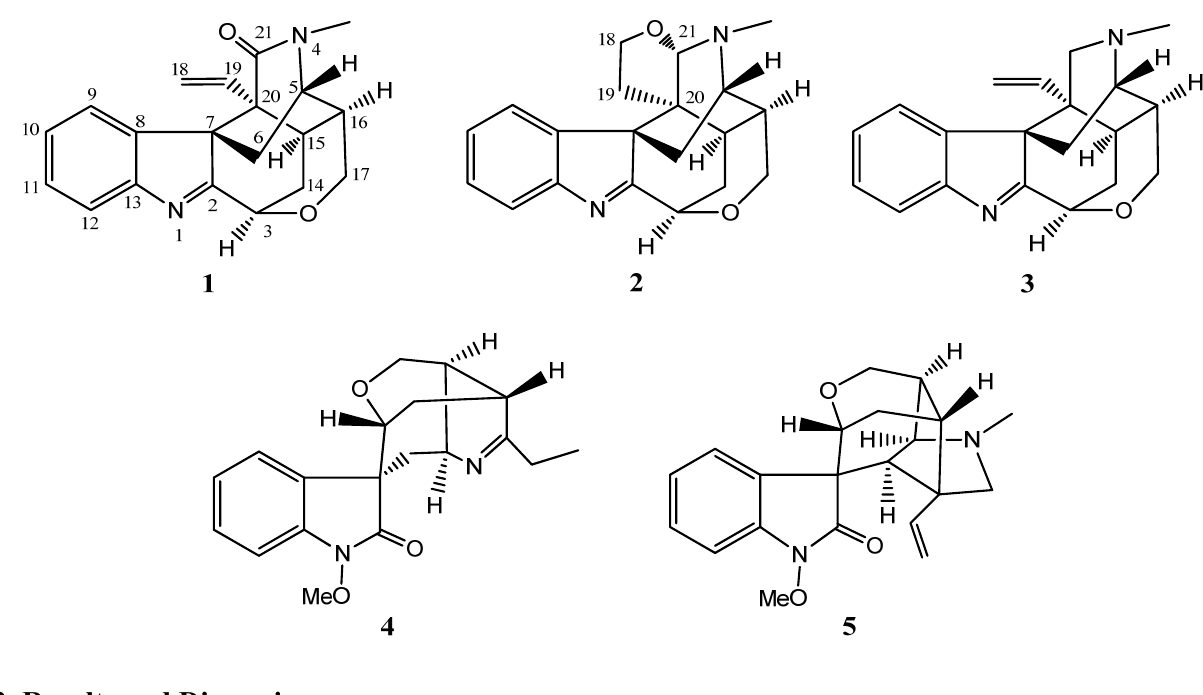
Figure 1. Chemical structures of compounds 1 – 5